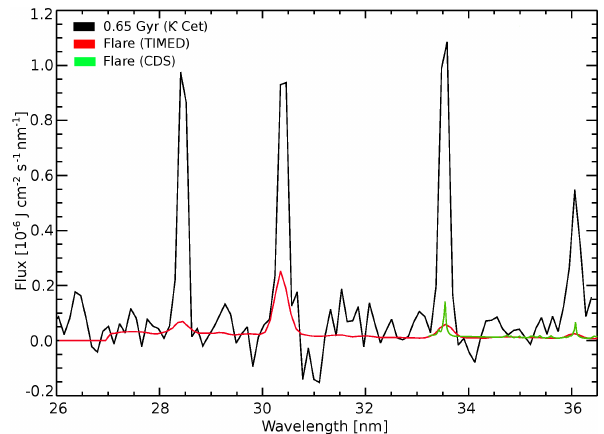
Fig. 3. Flare spectrum in nm during the maximum of the X17.2 flare on 28 October 2003 at 11:02UT shown as green (SOHO/CDS) with a resolution of 0.03nm and red (TIMED/SEE) at 11:17UT with a resolution of 0.4nm. The black spectrum illustrates the quiet Sun during moderate solar activity with the intensity flux being 2.5 times lower than during the flare.